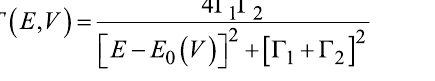
finding may be due to the inherent asymmetric contact geom- etry and different chemical